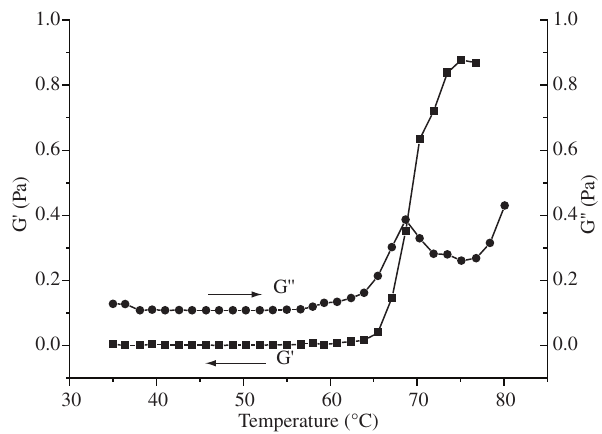
Figure 2. Rheograms showing the elastic (G’) and viscous (G”) moduli of the suspension with 6 wt. (%) albumin, as a function of temperature.